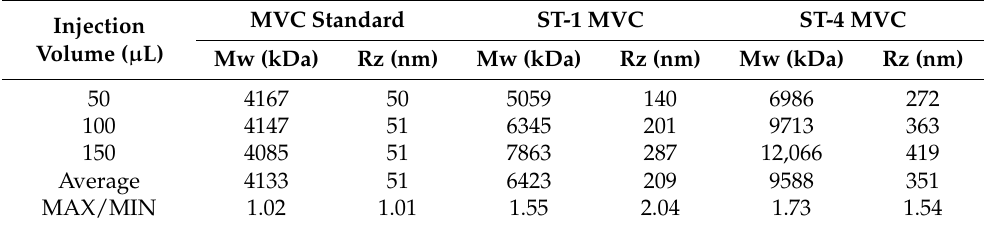
Table 1. Mw and Rz for MVCs from SEC-MALS. Zimm 1st order fit was used.